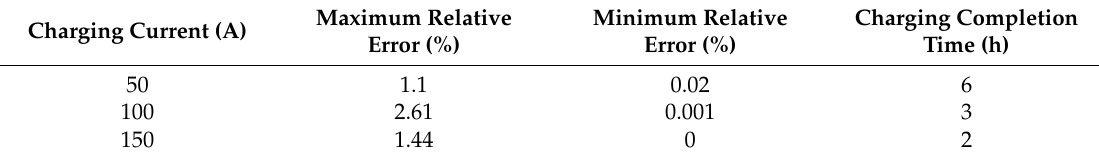
Figure 9. ( a ) Simulation results and experimental verification of ZNBs voltage at 100 A discharging current; ( b ) relative error between simulation results considering self-discharge and experimental results.